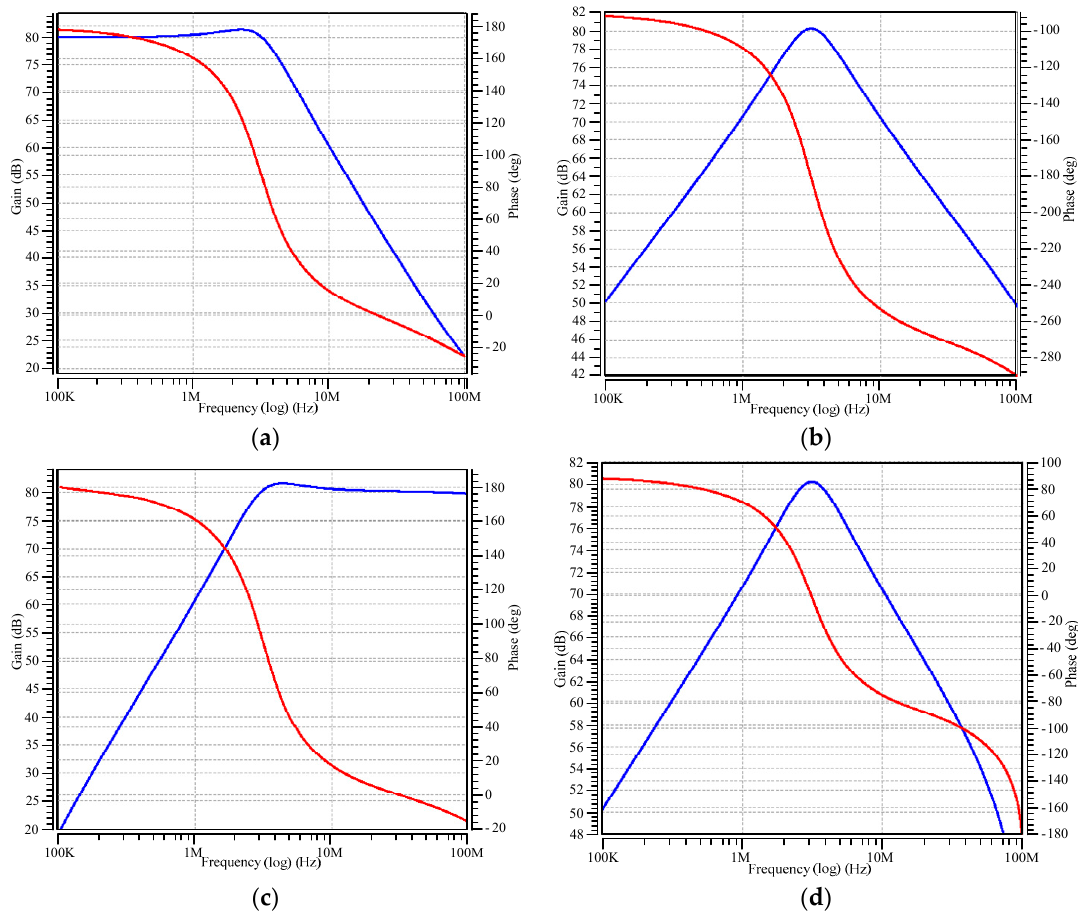
Figure 19. The TIM post-layout gain (blue line) and phase (red line) simulation responses ( a ) lowpass filter (V o1 /I in ); ( b ) bandpass filter (V o2 /I in ); ( c ) highpass filter (V o3 /I in ); and ( d ) bandpass filter (V o4 /I in ).